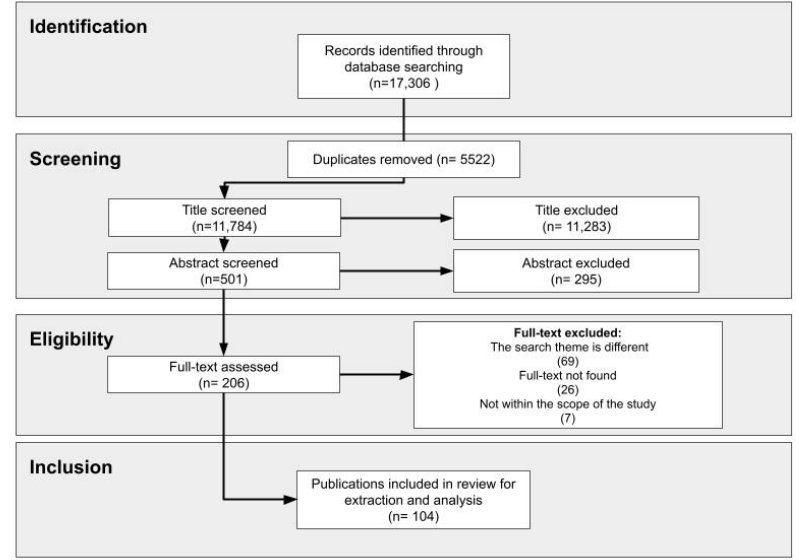
Figure 1. Study selection flow diagram.